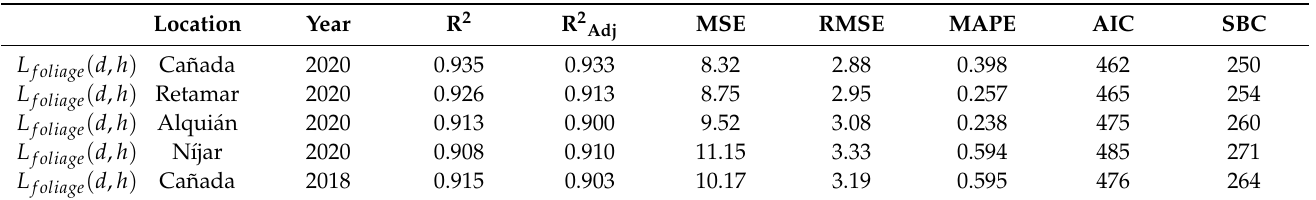
Table 2. Statistical quality assessment of the proposed deep learning model for other five greenhouses measurements.